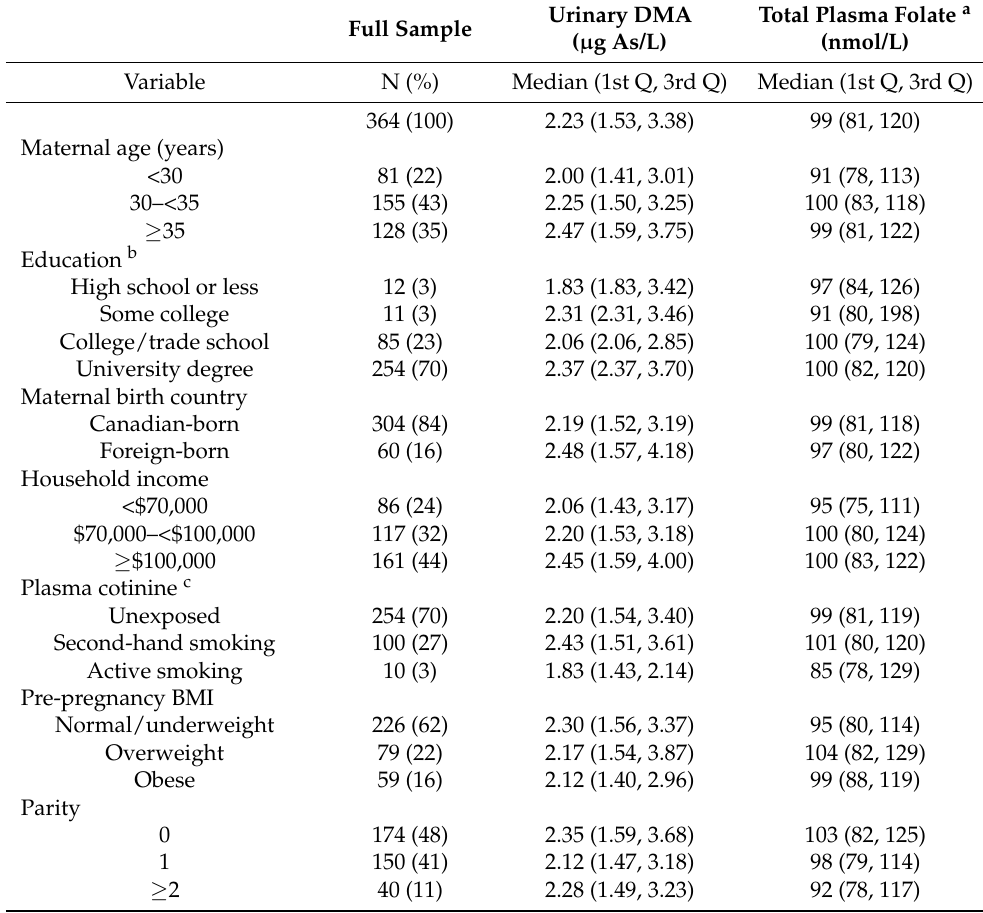
Table 1. Maternal first trimester urinary DMA concentrations and total plasma folate concentrations by sociodemographic and perinatal characteristics among MIREC study participants.